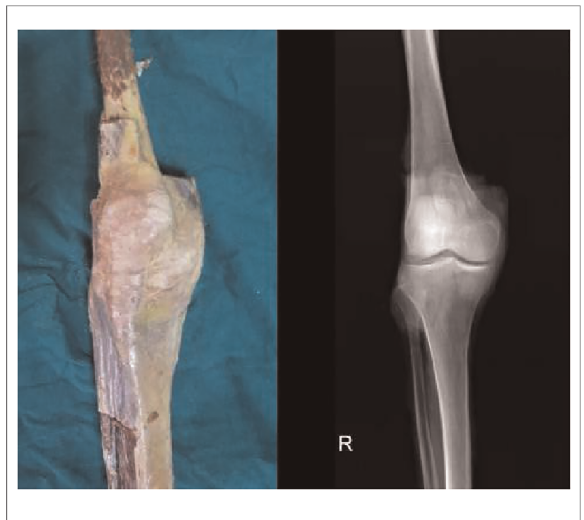
FIGURE 1 General photograph and x-ray of a cadaveric